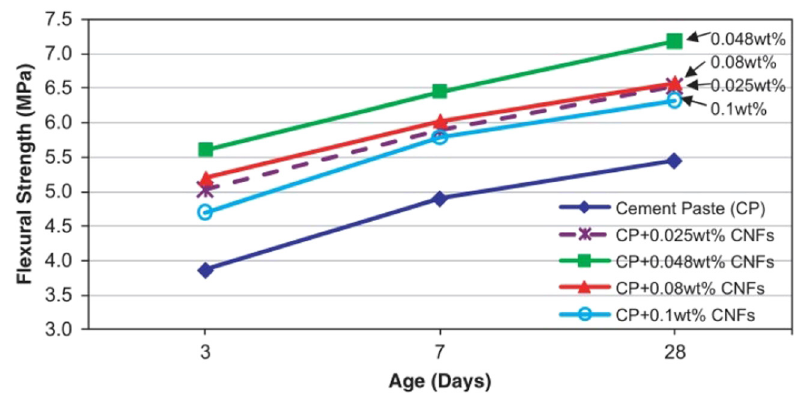
Figure 16: E ff ect of CNF concentration on fl exural strength of cement paste [ 146 ]